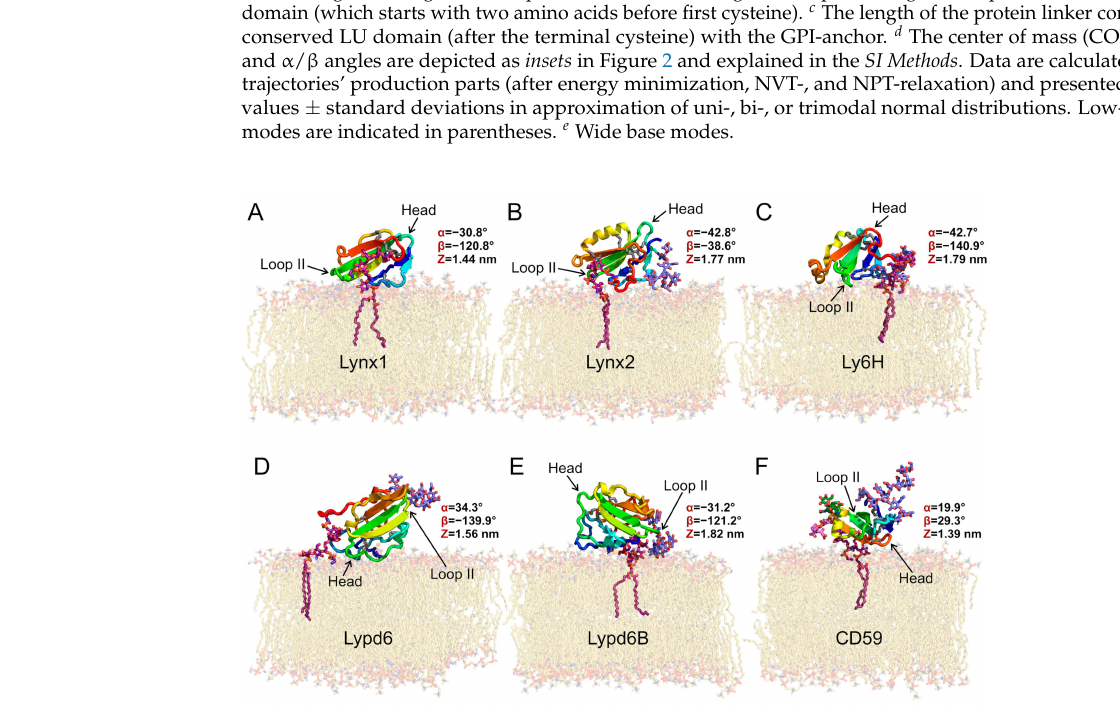
Figure 1. Preferential orientations of GPI-anchored Ly6 proteins in the membrane: Lynx1 ( A ), Lynx2 ( B ), Ly6H ( C ), Lypd6 ( D ), Lypd6B ( E ), and CD59 ( F ). Molecules are colored from blue ( N -terminus) to red ( C -terminus); disulfide bonds are shown as sticks (sulfur and C α atoms are gray ); carbon atoms of GPI-anchors are purple ; N-glycans are lavender blue ; O-glucans of CD59 are pink and green ; and lipids are beige . All presented proteins except for Lynx1 have N-glycans; CD59 has also two O-glycans. Ly6 proteins adopt different orientations relative to the membrane, forming contacts with membrane via polypeptide fragments and glycans (Table 2). These snapshots represent the most populated clusters from MD (see Figure 4). Variables triad ( α , β , and Z) values (see Figures 2 and S3–S5) are given for the most preferential configurations according to MD simulations